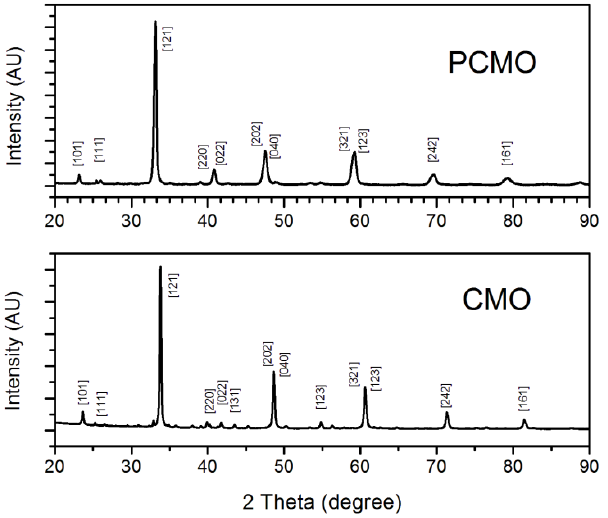
Figure 1. XRD patterns of CaMnO 3 (CMO) and Pr 1-x Ca x MnO 3 (PCMO). The indices correspond to the space group Pnma.